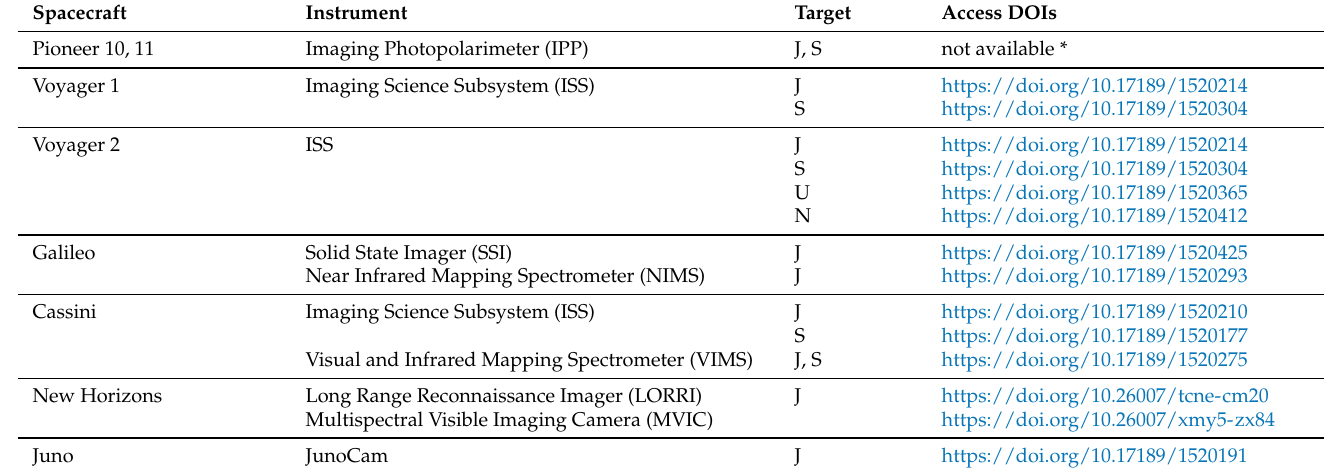
Table 1. Optical and near-infrared imagers used for remote sensing of Jupiter (J), Saturn (S), Uranus (U) and Neptune (N), and the Digital Object Identifiers (DOIs) for accessing the data. All links in this table were accessed on 30 October 2022.